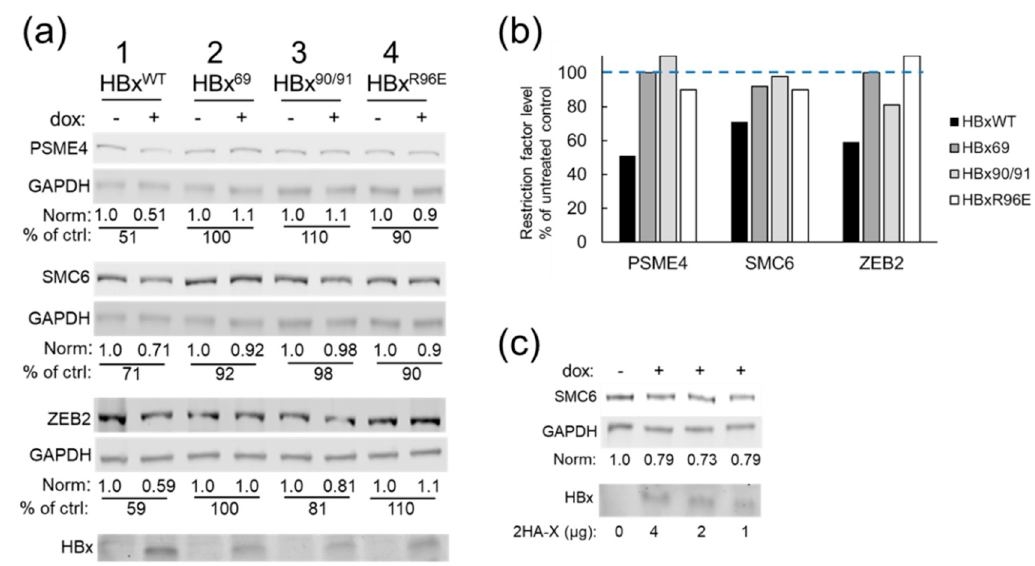
Figure 5. HBx WT -DDB1 binding mediates reduced levels of putative restriction factors. ( a )